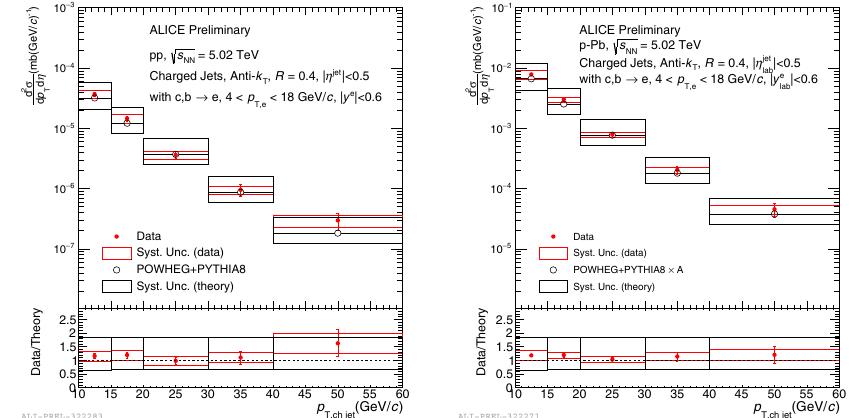
Figure 3. p T -di ff erential cross section of jets tagged with electrons from heavy-flavour hadron decay in pp (left panel) and p–Pb (right panel) collisions at √ s NN = 5.02 TeV. 68 jets tagged with electrons from heavy-flavour hadron decays in pp and p–Pb collisions at 69 √ s NN = 5.02 TeV on the left and the right panels, respectively. The jets are identified by 70 the presence of heavy-flavour decay electrons within 4 < p T , e < 18 GeV / c . The results have 71 been compared with the next to leading order (NLO) perturbative QCD calculations using 72 POWHEG + PYTHIA8 [4, 8] and are found to be in good agreement with NLO pQCD 73 predictions.